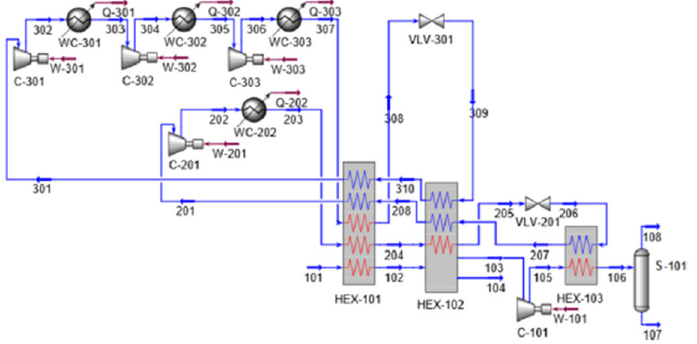
Figure 52. Phase diagram of CH 4 -CO 2 binary system at different CO 2 contents [203].